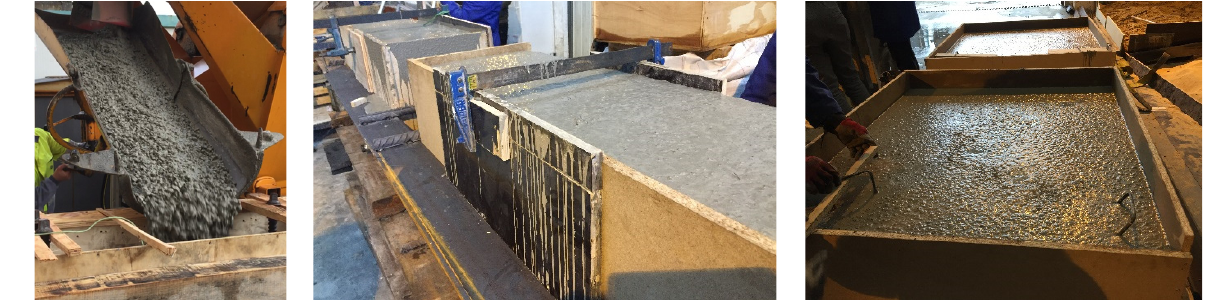
Figure 4 . Concrete pouring ( left ), BV ( centre ), and BH ( right ). Figure 4. Concrete pouring ( left ), BV ( centre ), and BH ( right ).